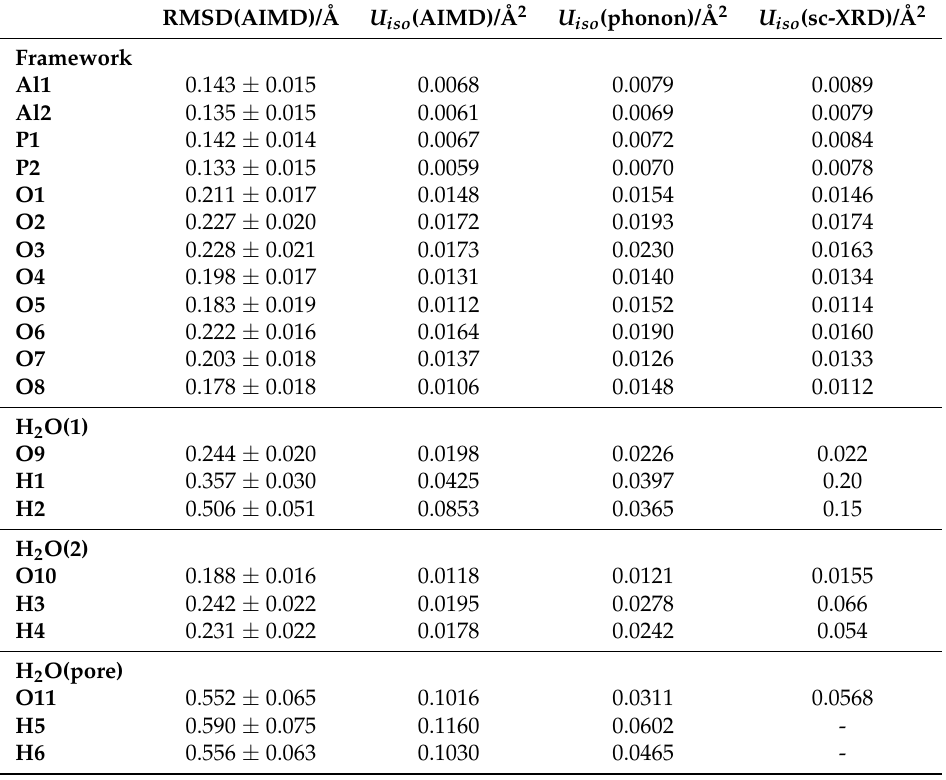
Table 6. Root mean square displacements and isotropic discplacement parameters U iso obtained from AIMD calculations as well as U iso obtained from phonon calculations. Experimental values are given for comparison